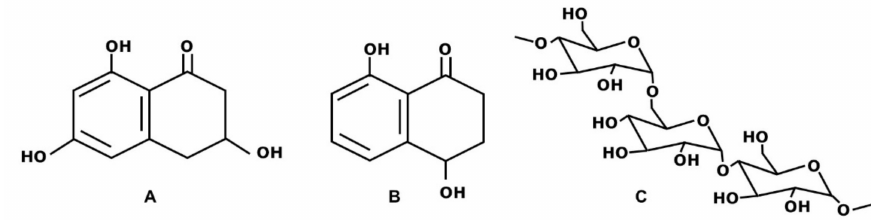
Figure 1. Structure formulae of scytalone ( A ), isosclerone ( B ) and pullulan ( C